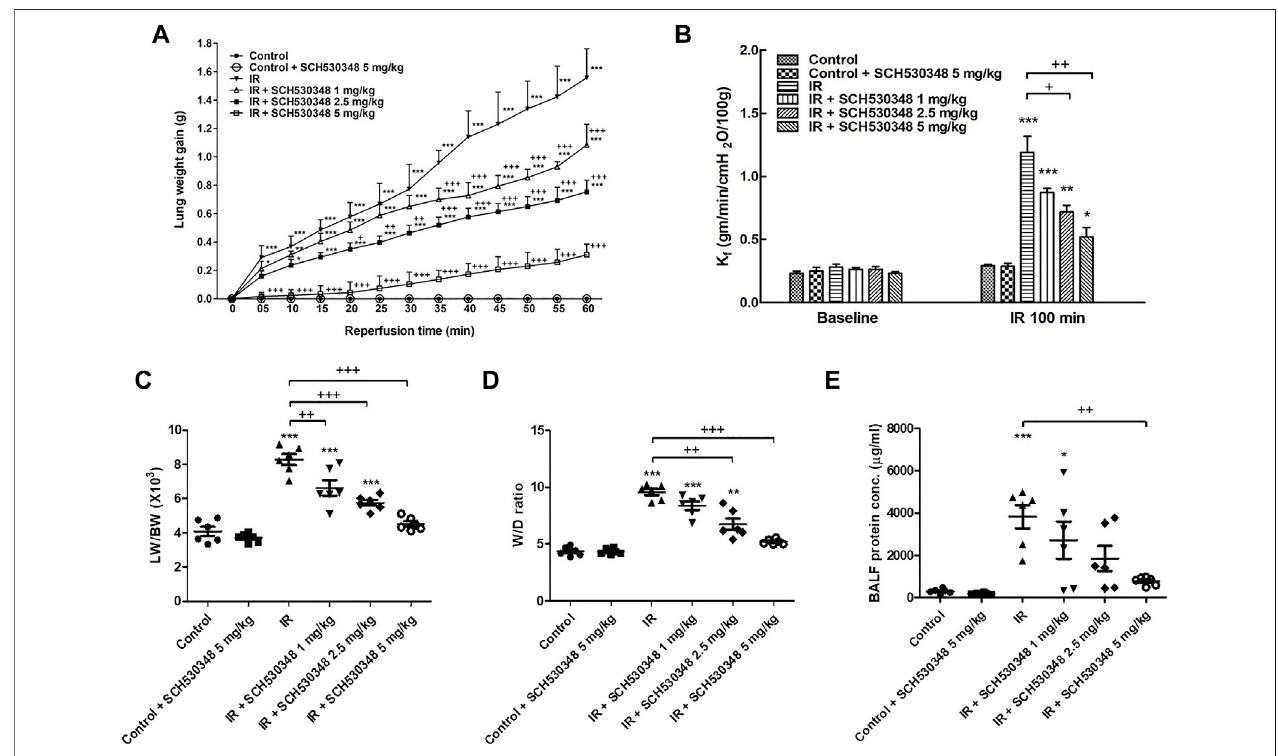
FIGURE1| SCH530348alleviatedIR-inducedacutelungedema. (A) LWgain, (B) K f , (C) LW/BWratio, (D) W/Dweightratio,and (E) proteinconcentrationinBALF signi fi cantly increased in the IR group. The increases in these parameters were signi fi cantly ameliorated by SCH530348. Compared with other doses, 5 mg/kg SCH530348 was more effective in decreasing lung edema. The data are expressed as the mean ± SD ( n (cid:1) 6 per group). * p < 0.05, ** p < 0.01, *** p < 0.001, compared with the control group; + p < 0.05, ++ p < 0.01, +++ p < 0.001, compared with the IR group.